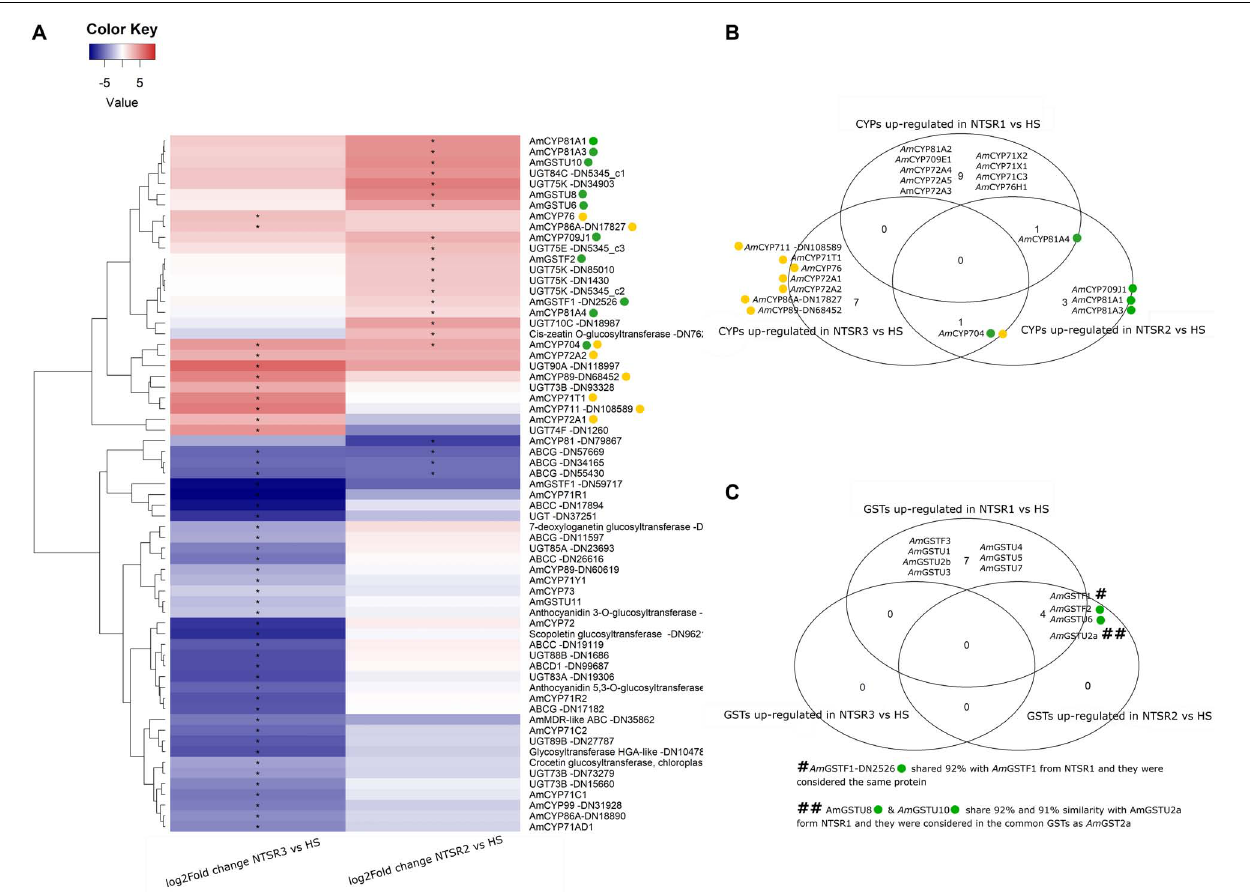
FIGURE 5 | (A) Heatmap of the log 2 of the fold change of the xenome genes (including CYPs, GSTs, UGTs, and ABCs) of the NTSR2 vs. HS and NTSR3 vs. HS. Star in represent the FDR ≤ 0.05. Clustering dendrogram of the samples based on the log 2 FC was represented at the left of the heatmap. (B) Venn diagram representing the CYPs upregulated (log 2 FC ≥ 1 and FDR ≤ 0.05) in NTSR1, NTSR2, and NTSR3 vs. HS. (C) Venn diagram representing the GSTs upregulated (log 2 FC ≥ 1 and FDR ≤ 0.05) in NTSR1, NTSR2, and NTSR3 vs. HS. CYPs and GSTs upregulated in NTSR3 and NTSR2 were highlighted using yellow and green circles, respectively, in the heatmap and the Venn diagrams. HS, sensitive population; NTSR1, Peldon in-field population with broad-ranging resistance to post-emergence herbicides; NTSR2, derived from HS and selected for resistance to pendimethalin; NTSR3, derived from HS and selected for resistance to fenoxaprop- P -ethyl; FDR, false discovery rate; CYPs, cytochrome P450s; GSTs, glutathione transferases.